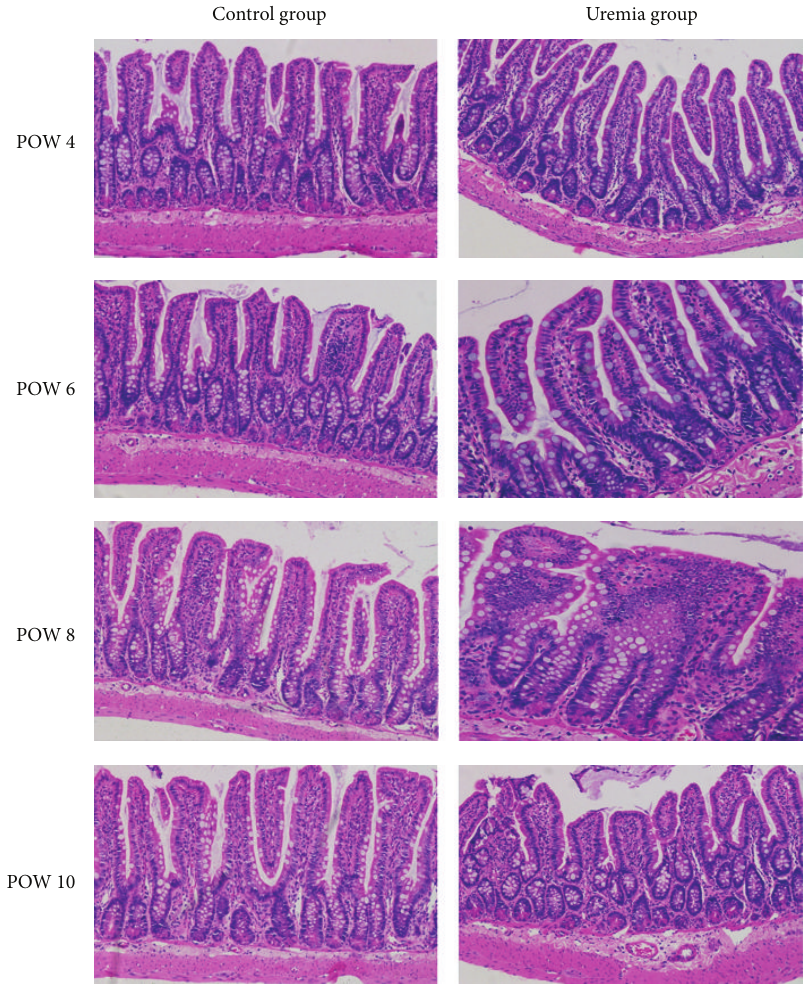
Figure 5: Representative microscopic changes of the intestinal tissue stained with H&E using light microscopy (100x) in each group. POW: postoperative week. There were time-dependent edema and inflammation in the intestinal mucosa and submucosa in uremia group when compared with those in the control group, especially in postoperative weeks 8 and